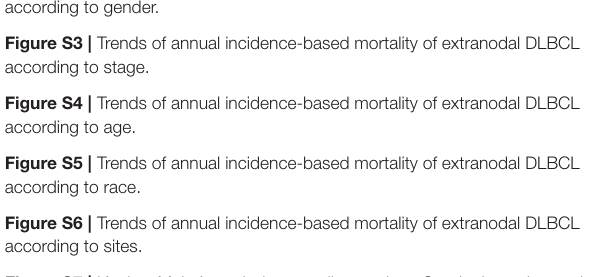
Table S1 | Demographics and clinical characteristics of the patients included in the construction of the nomograms (2002–2015): The SEER-18 Registry Database. Table S2 | Univariate and multivariate analysis of prognostic factors for overall survival in extranodal diffuse large B-Cell Lymphoma Patients included in the construction of the nomograms (2002–2015): The SEER-18 Registry Database. Figure S1 | The overall trends of incidence-based mortality of extranodal DLBCL. Figure S2 | Trends of annual incidence-based mortality of extranodal DLBCL according to gender. Figure S3 | Trends of annual incidence-based mortality of extranodal DLBCL according to stage. Figure S4 | Trends of annual incidence-based mortality of extranodal DLBCL according to age. Figure S5 | Trends of annual incidence-based mortality of extranodal DLBCL according to race. Figure S6 | Trends of annual incidence-based mortality of extranodal DLBCL according to sites. Figure S7 | Kaplan–Meier’s analysis according to sites. Graph shows increasing survival from the 1970s to 2000s. (A) Overall survival in Skin and soft tissue; (B) Overall survival in Gastrointestinal tract; (C) Overall survival in Skeletal tissue. (D) Overall survival in Respiratory system; (E) Overall survival in Liver/pancreas; (F) Overall survival in Breast tissue; (G) Overall survival in Genitourinary tract; (H) Overall survival in